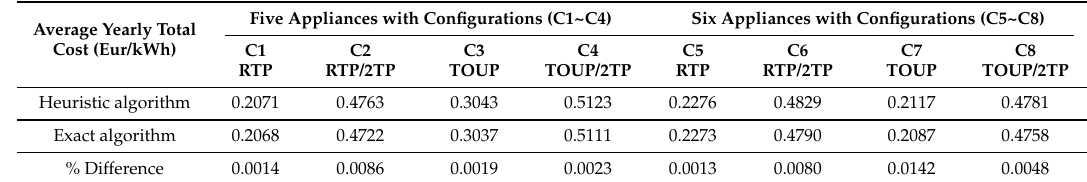
Simulation result for multiple households with five & six appliances with different configurations and pricing